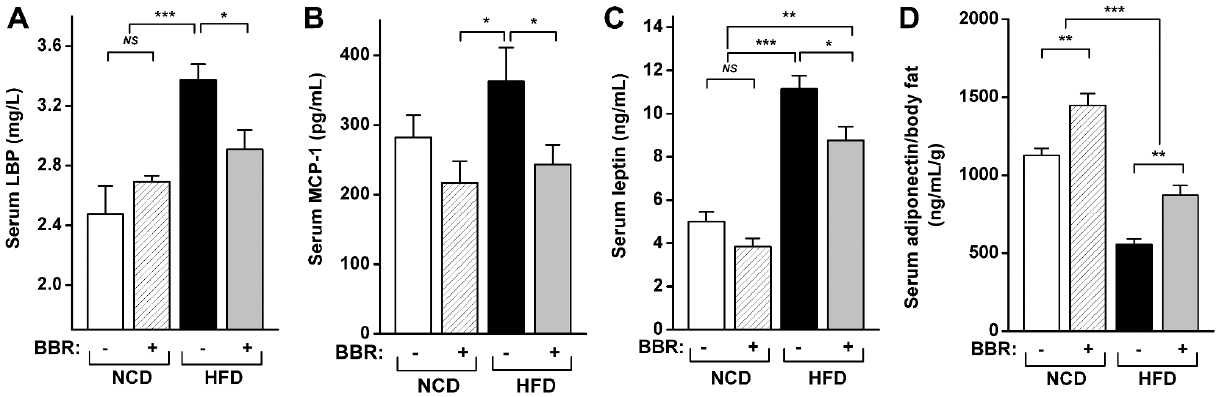
Figure 3. Influences of berberine on systemic inflammation in HFD-fed rats. (A) Serum LBP; (B) serum leptin; (C) serum MCP-1; (D) serum adiponectin corrected for body fat. Values are expressed as means 6 standard error. Differences were assessed by ANOVA and denoted as follows: * P , 0.05; ** P , 0.01; *** P , 0.001; NS not significant.